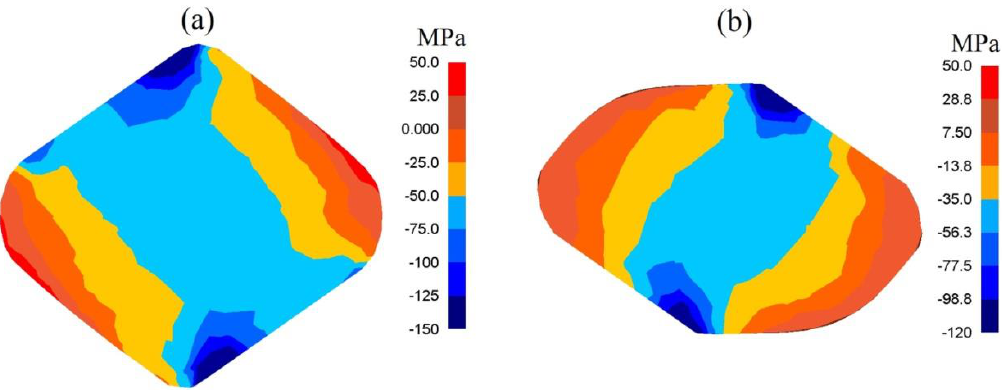
Figure 9. Distribution of mean stresses after the cogging process in anvils with skew working surfaces: ( a ) after the second pass (reduction ratio 0.70); ( b ) after the fourth pass (reduction ratio 1.40).